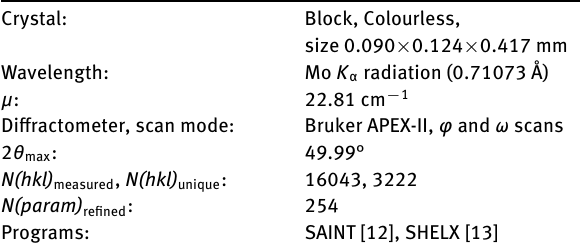
Table 1: Data collection and